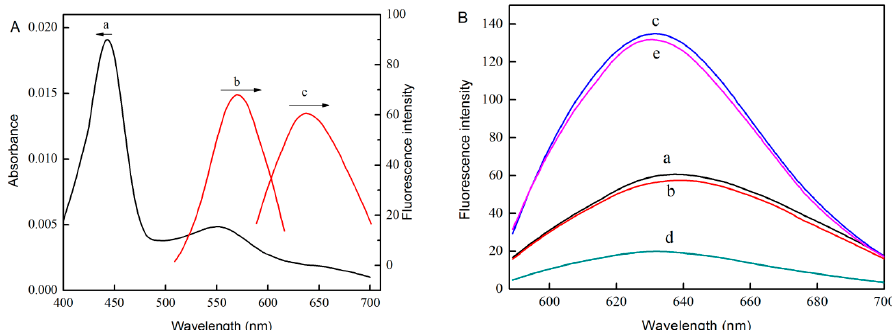
Figure 1. UV-Vis (curve a), excitation (curve b), and emission (curves c) spectra of dC 12 -AgNCs ( A ). Fluorescence spectrum of dC 12 -AgNCs at different conditions ( B ): (a) 2.0 μ M dC 12 -AgNCs; (b) 2.0 μ M dC 12 -AgNCs + 20.0 μ g/mL GO; (c) 2.0 μ M dC 12 -AgNCs + 200 nM peptide; (d) 2.0 μ M dC 12 -AgNCs + 200 nM peptide + 20.0 μ g/mL GO; (e) 2.0 μ M dC 12 -AgNCs + 200 nM peptide + 200 ng/mL trypsin + 20.0 μ g/mL GO.